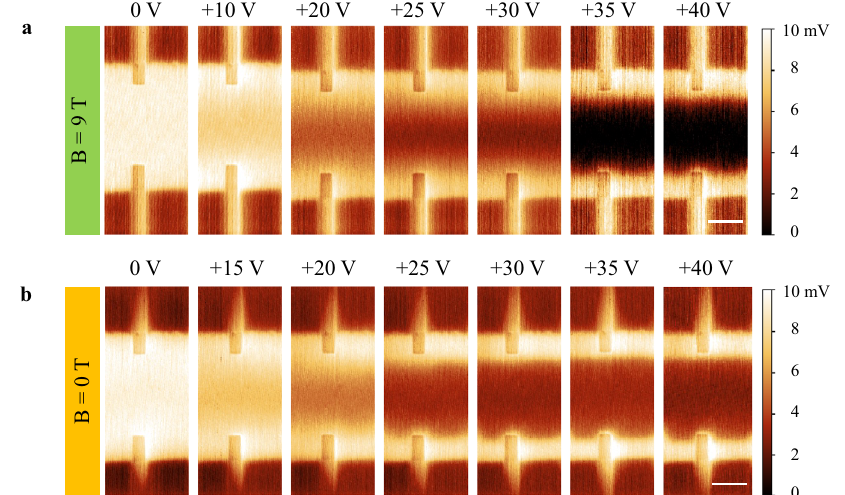
Fig. 2 | Gate voltagedependent sMIM imaging.a Gate voltage dependentsMIM images at9T. The scalebaris3 μ m. b Gate voltagedependentsMIM images at 0T.The scale bar is 3 μ